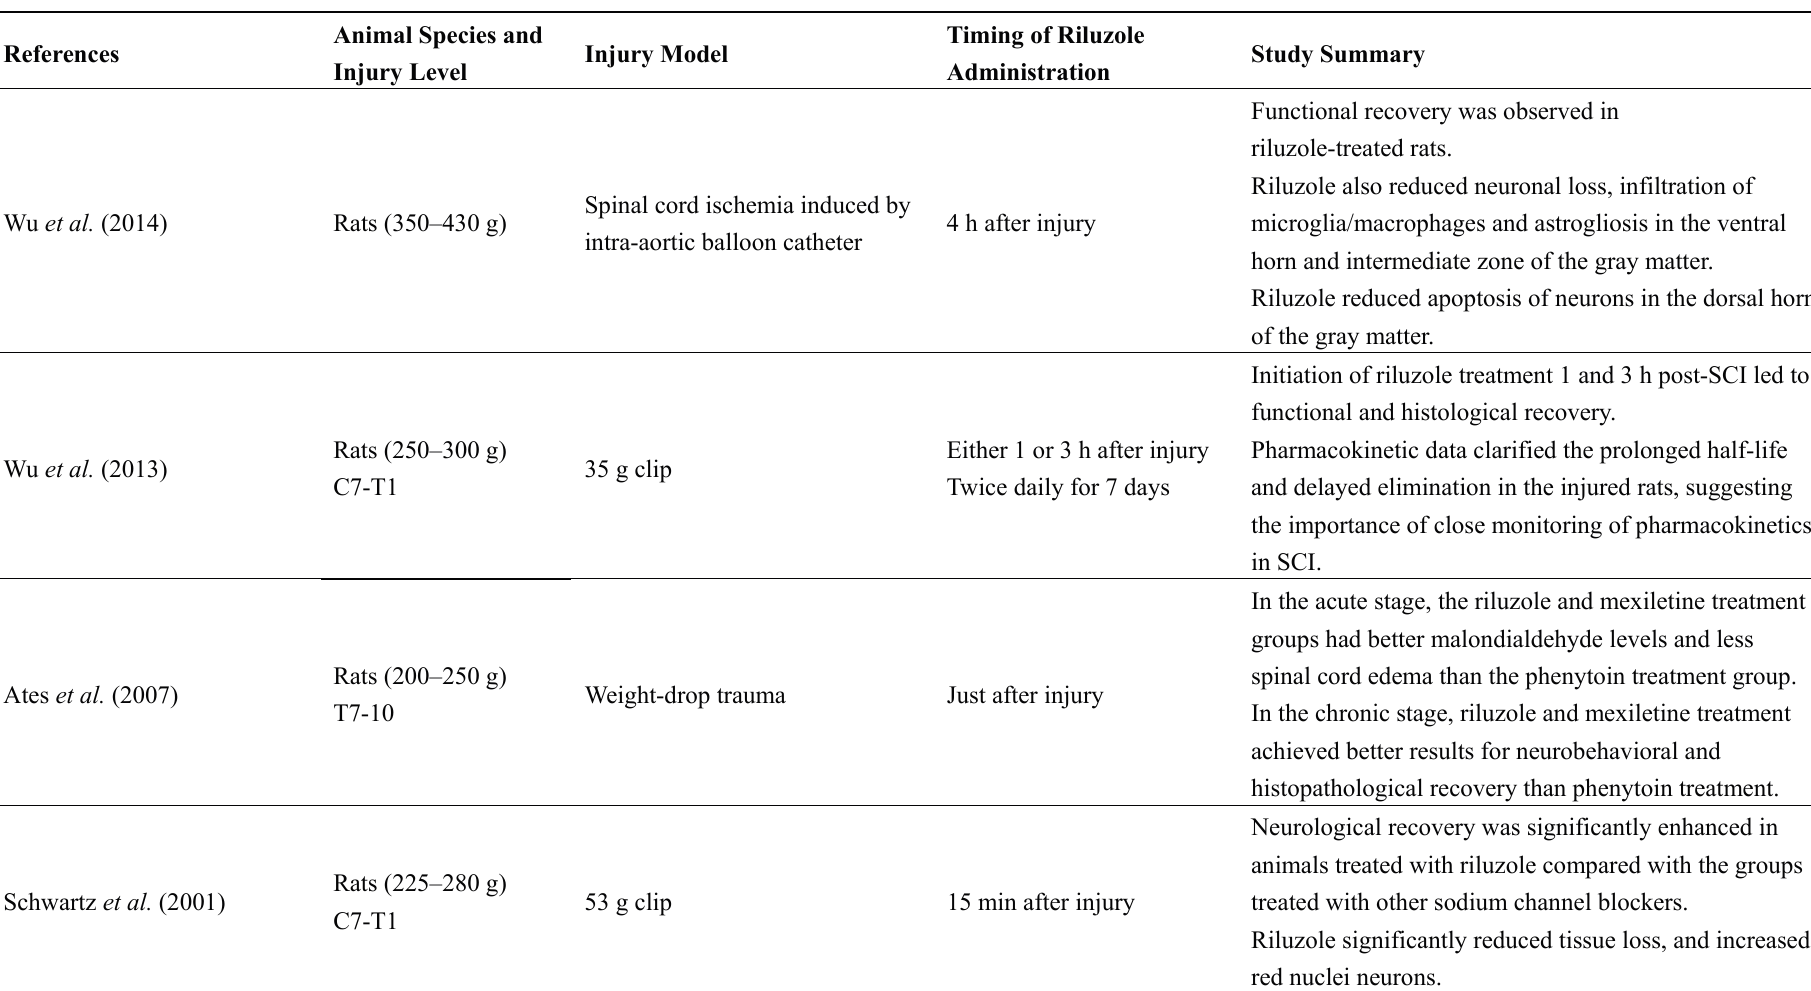
Table 1. Preclinical study to examine the efficacy of riluzole for